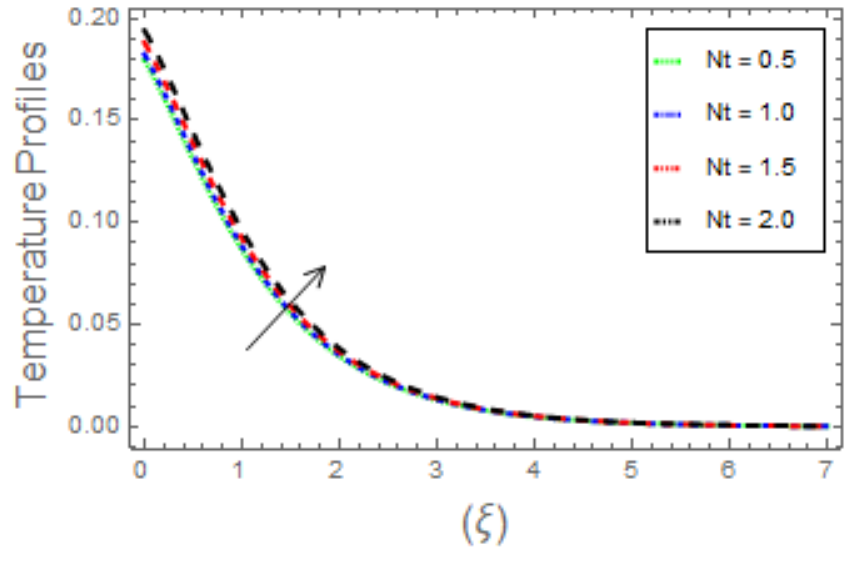
Figure 13. Variation in T due to Nt . is detected, which is subjected to larger Nt assessments. Physically, an upsurge in